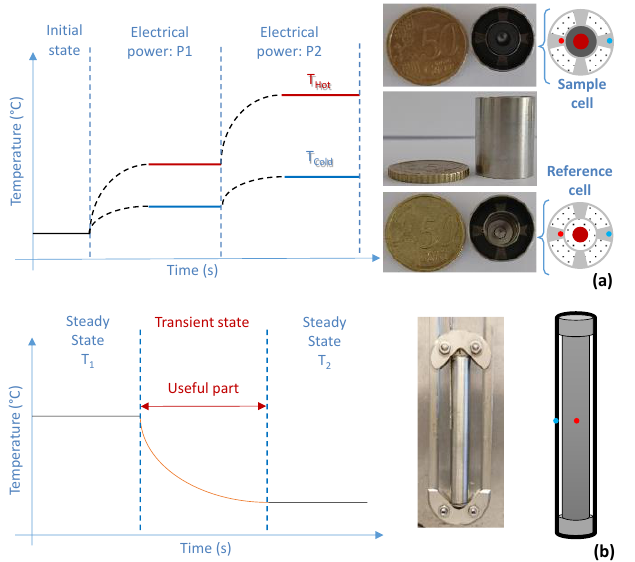
Fig. 1 Calibration protocols for: (a) Differential calorimeters; (b) Single-cell calorimeters.